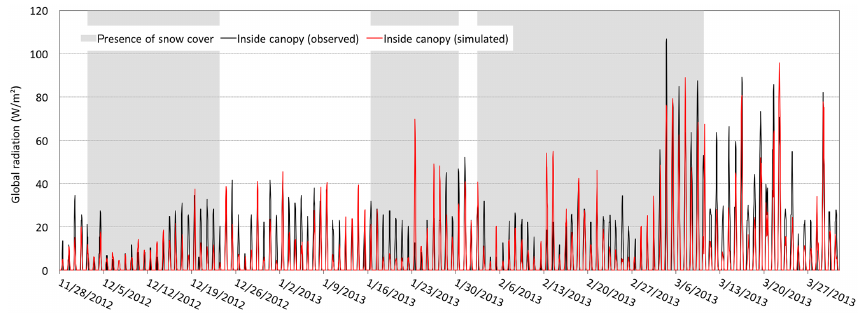
Figure 6. Simulated and observed global radiation for the winter period 2012/13 at site Vordersteinwald. The grey areas indicate periods with presence of a snow cover.